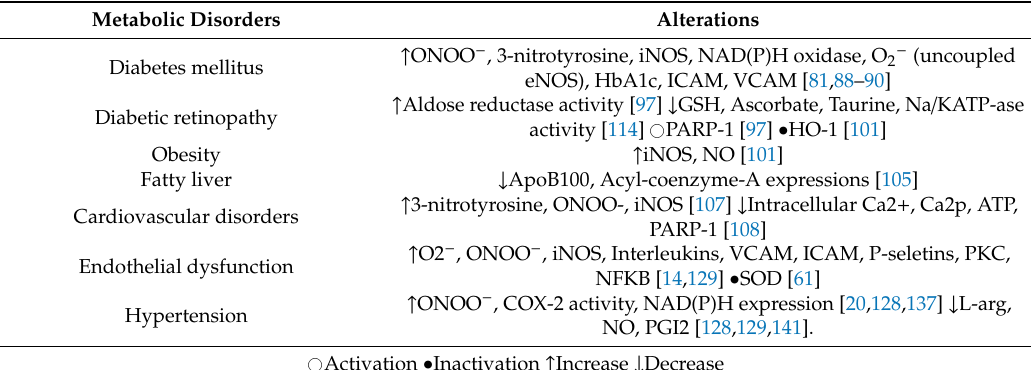
Table 1. Participation of nitrosative stress in cardiometabolic